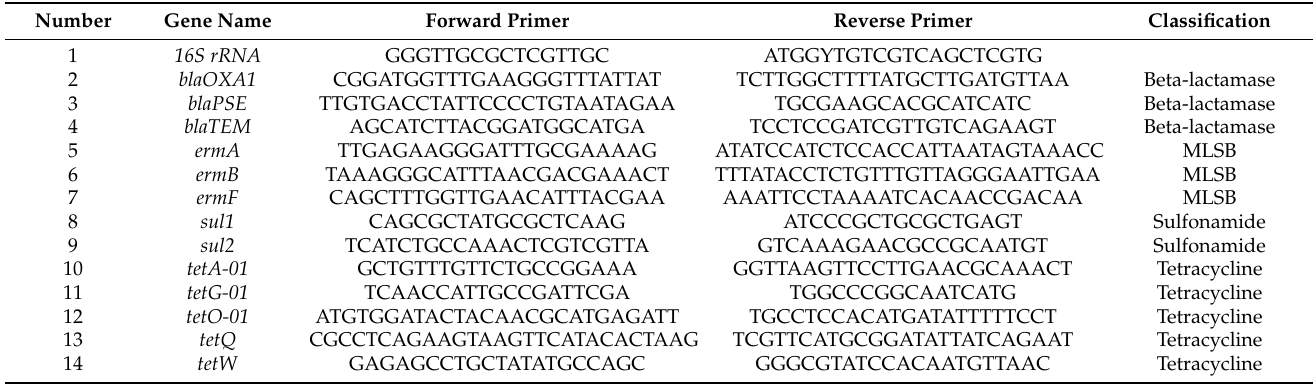
Table 1. Information of 14 genes’